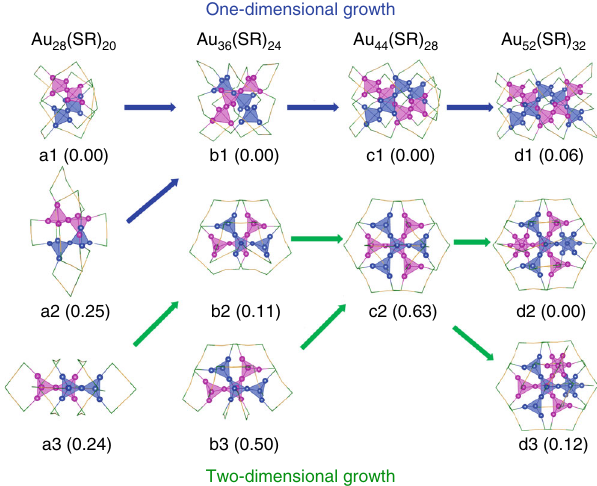
Fig. 1 The growth patterns of Au 8 n + 4 (SR) 4n + 8 ( n = 3 – 6) nanoclusters. The values in brackets are the relative energies (eV). Note that structures of a1/b1/c1/d1 (TBBT as ligand) and a2 (CHT as ligand) are experimentally determined. The arrows in blue and green denote the one-dimensional and two-dimensional growth, respectively. According to the relative energies, b2 of Au 36 (SR) 24 and d2 of Au 52 (SR) 32 are the most potential candidates among the predicted isomers. Color labels: green = S, blue/magenta/ yellow = Au. The C and H atoms are omitted for